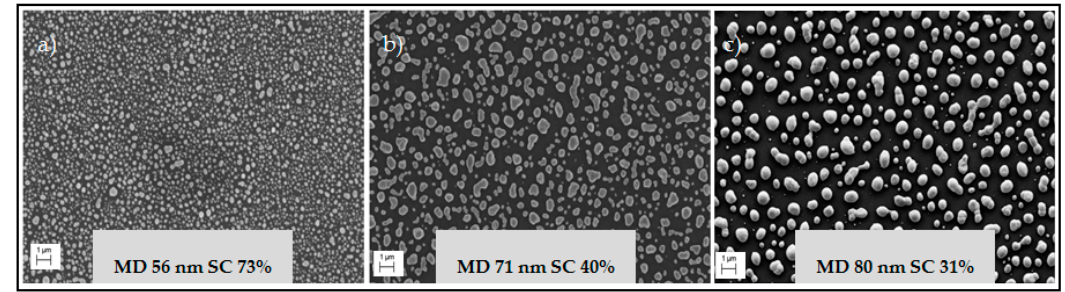
Figure 2. SEM images of printed nanoparticles after, ( a ) 3 min; ( b ) 5 min; ( c ) 7 min infrared (IR) sintering. Inkjet printed lines were used to produce trenches while dots were used to produce cavities.